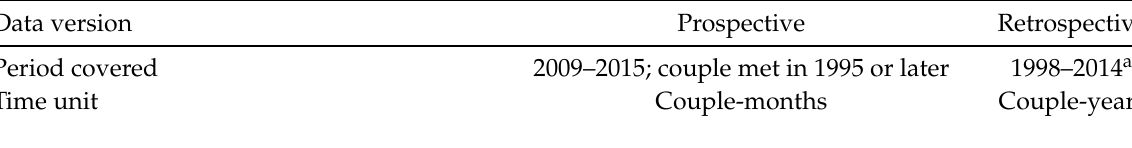
Table 1: Descriptive statistics for two event history data sets derived from the How Couples Meet and Stay Together